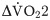
Scatter plots showing the relationship between the total number of high-intensity interval test repetitions and ΔV˙O22 (= V˙O2max − V˙O2 at 2 min during recovery; Panel A), ΔHR2/ (= (HRmax − HR at 2 min during recovery)/maximal HR; Panel B) or TSIINC (tissue saturation index at exhaustion; Panel C), determined by incremental exercise test data.